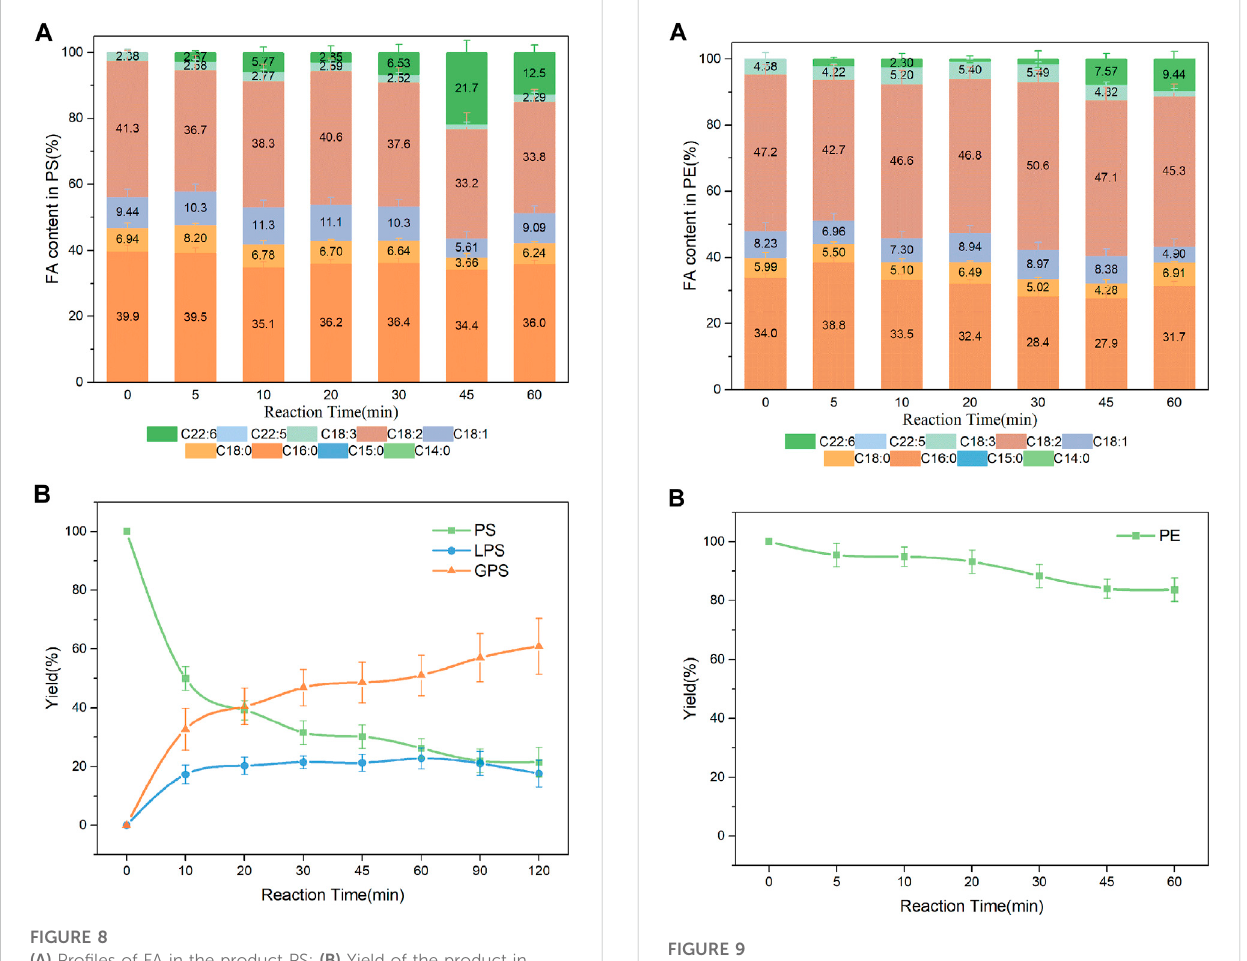
Figure S4. Both the DHA incorporation and LPC yield reached a maximum of 24.8% and 34.8%, respectively at 30 min. It was observed from Figure 9 that when the substrates were PE and DHA-TAG, both hydrolysis and transesteri fi cation activities were insigni fi cant.